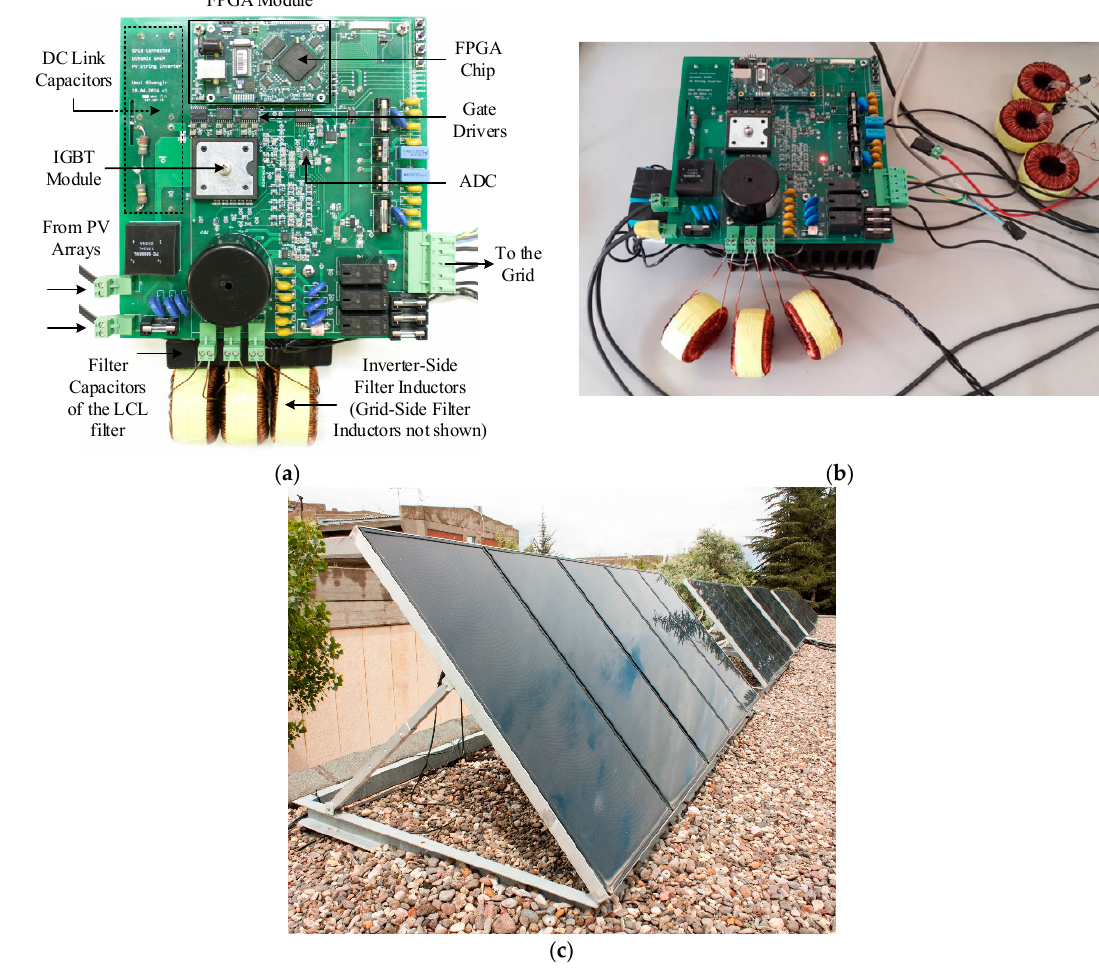
Figure 8. Experimental setup. ( a ) Power stage and controller (206 × 196 mm double ‐ layer printed circuit board (PCB)), ( b ) Grid connection of PV inverter through an LCL filter, ( c ) Two strings of the thin ‐ film PV panels used in the experiments.